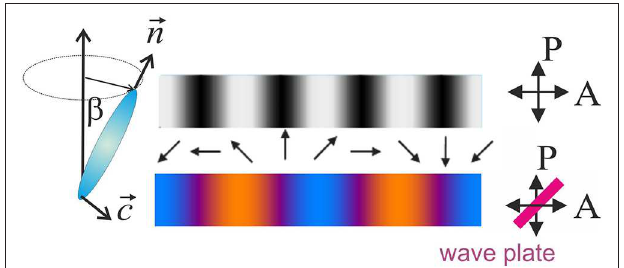
FIGURE 3 | C-director and optical appearance when the planar film is observed with crossed polarizers (top) and with crossed polarizers and diagonally inserted phase plate